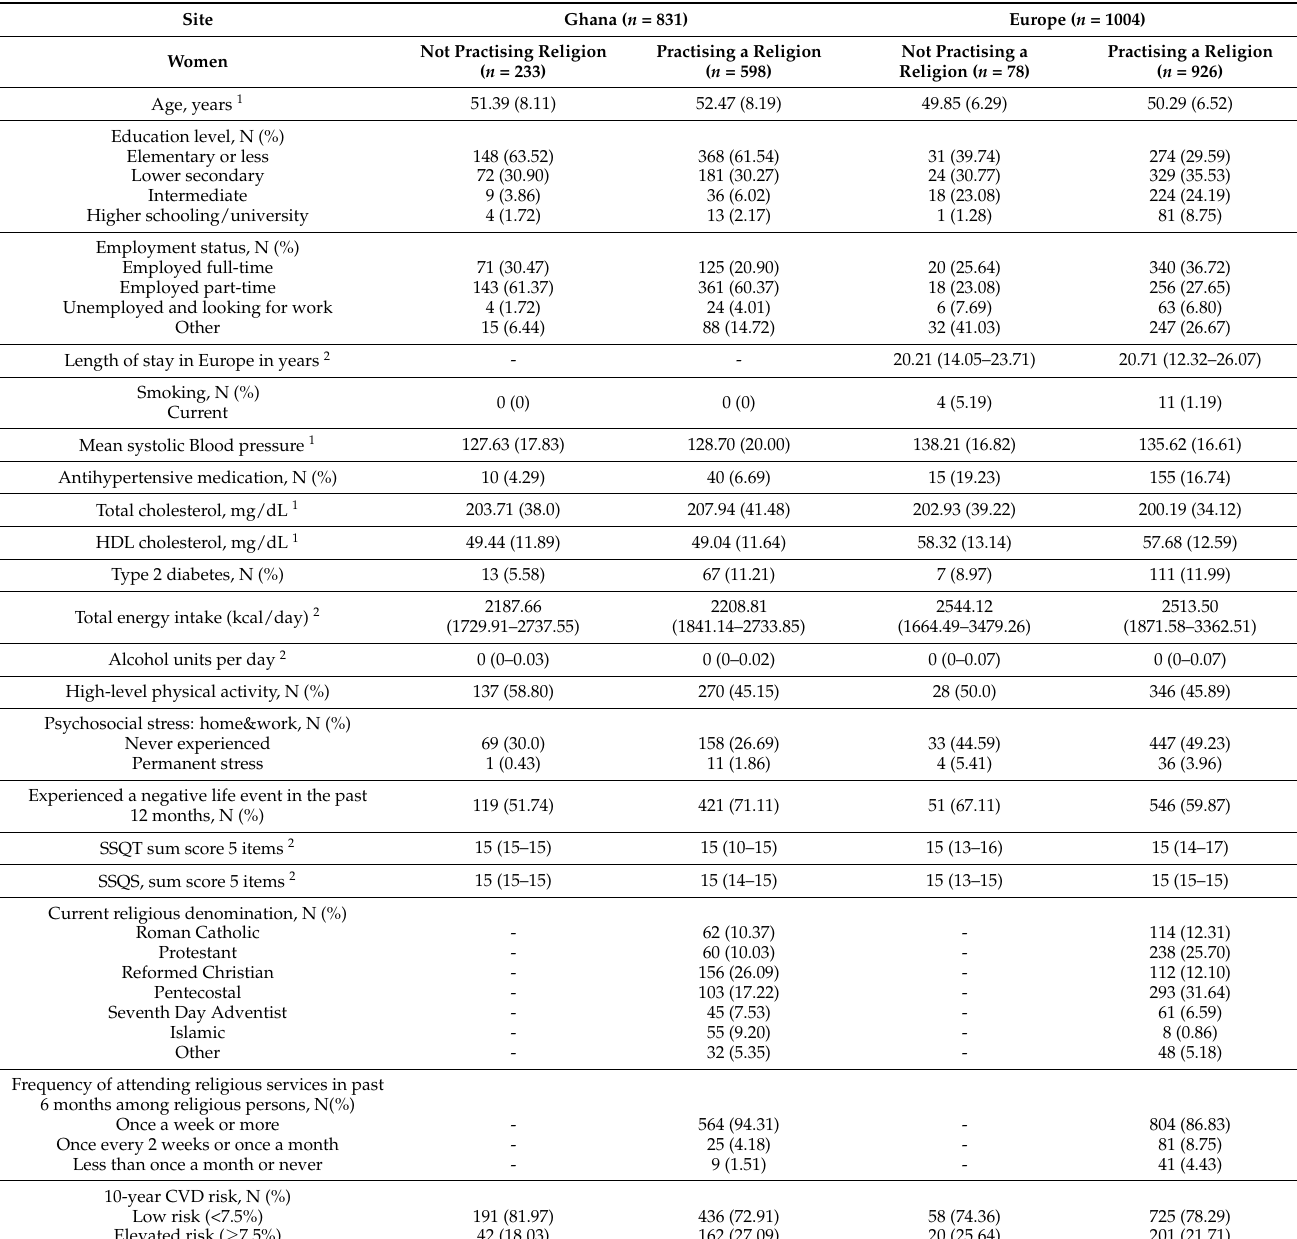
Table 2. General characteristics of the female RODAM study